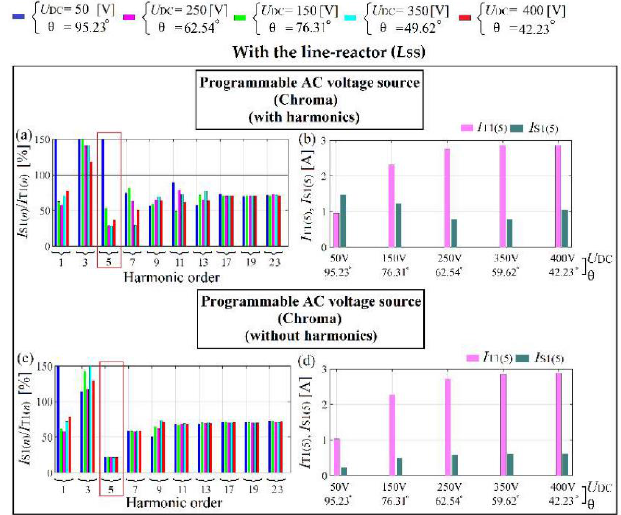
Figure 65. Summary comparison graph of the experiments performed after connecting the filter at the PCC between the programmable voltage source and the load: ( a , c ) filter efficiency and ( b , d ) the amplitude of the 5th harmonic current at the Chroma input ( I S(5) ) is compared to the one at load input ( I T(5) ). In ( a , c ), the amplitudes above 100% mean harmonic amplification at the Chroma input. The graphs are well described in the text. Figure 66. Summary comparison graph of the experiments performed after connecting the filter at the PCC between the grid and the load: ( a , c ) filter efficiency and ( b , d ) the amplitude of the 5th harmonic current at the grid side ( I S(5) ) is compared to the one at load side ( I T(5) ). The graphs are well described in the